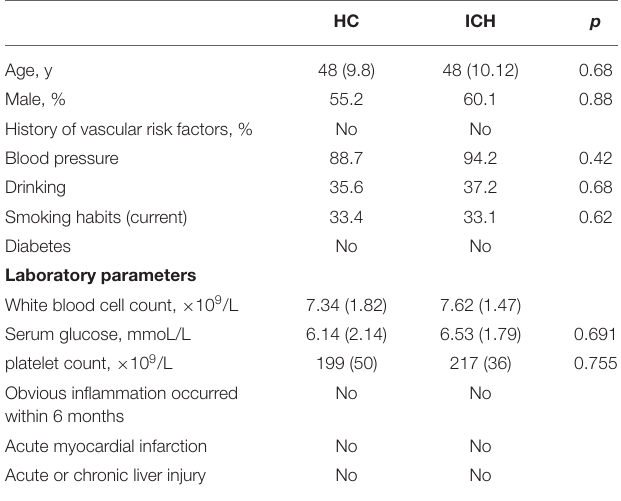
TABLE 1 | Clinical features of ICH patients and healthy